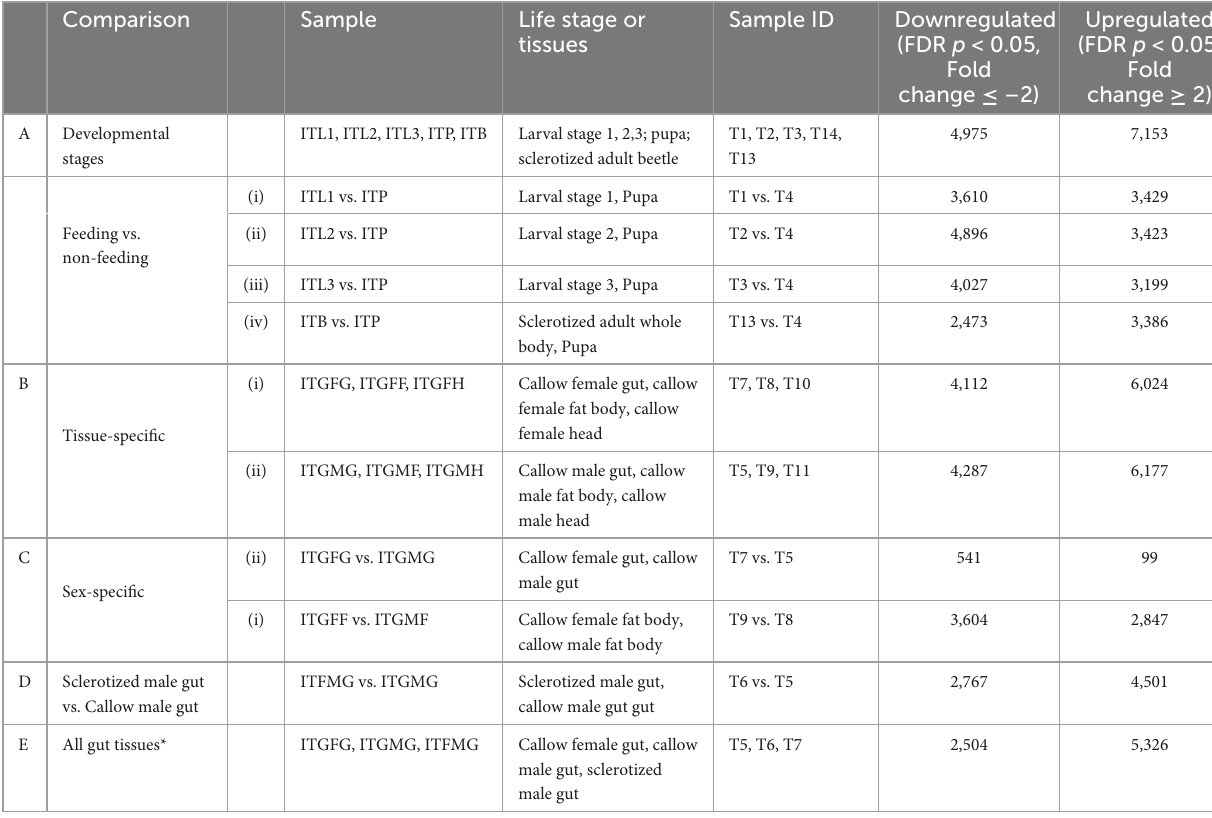
TABLE 1 The number of differentially expressed genes in various comparisons.